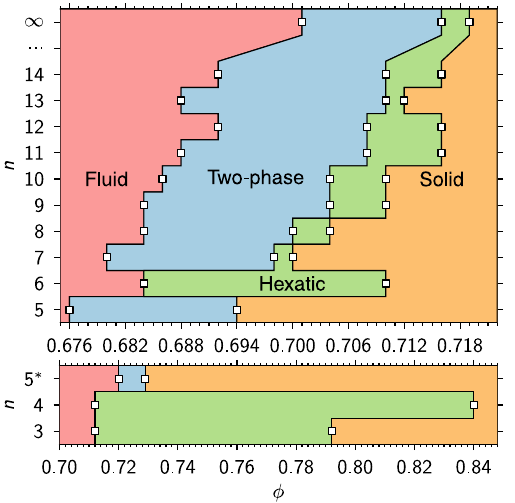
FIG. 7. Phase diagram of hard polygon melting behavior. Disk results ( n → ∞ ) are from Refs. [12,25]. The label 5 (cid:2) refers to the fourfold pentille. The n ¼ 3 solid is a honeycomb lattice with alternating triangle orientations, the n ¼ 4 solid is a square lattice, and the n ≥ 5 solids are all